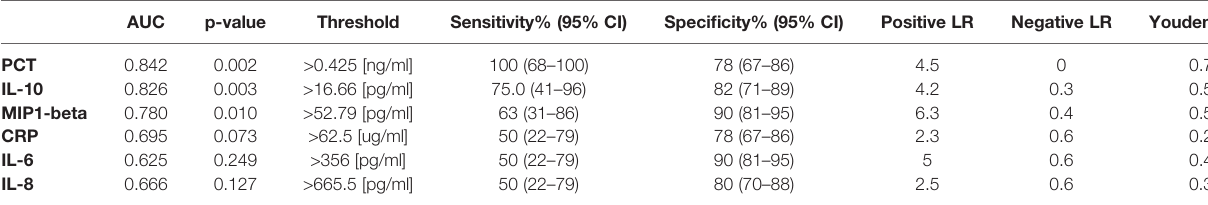
TABLE 3 | Performance of biomarkers to predict bacteraemia at FN presentation (Day 1).